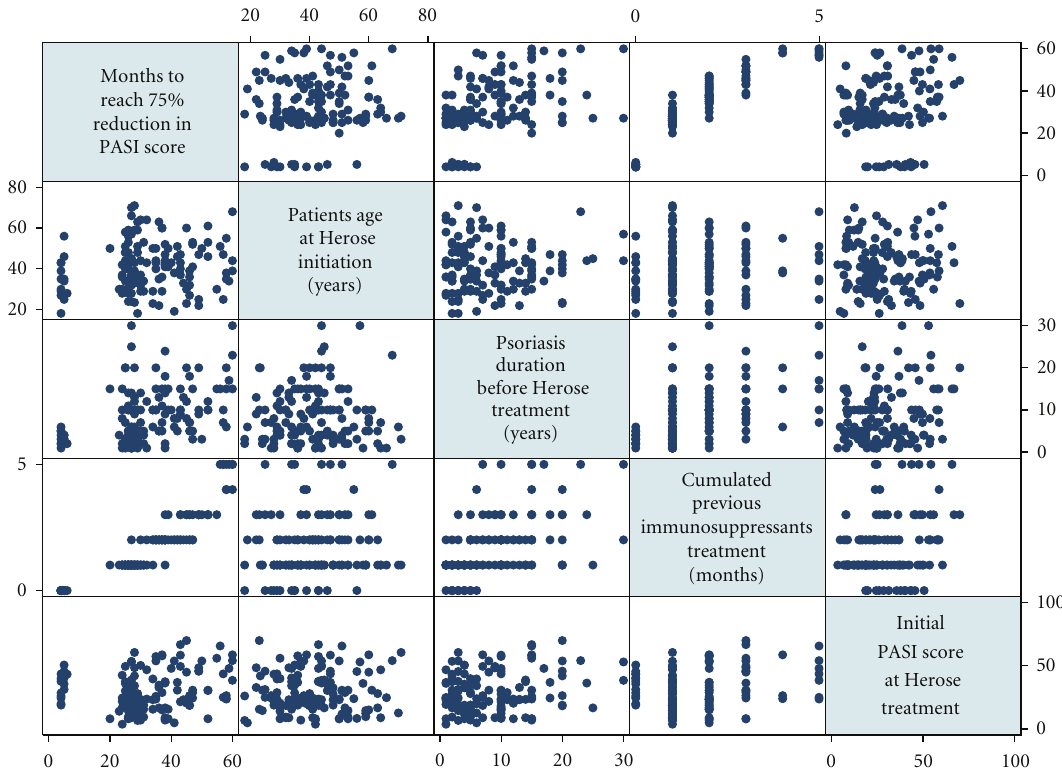
Figure 4: Correlation between months required reaching 75% reduction in PASI score and cumulated prior immunosuppressive treatment is strong ( r = 0 . 9154) however the correlations to other factors, patients age, psoriasis duration, and initial PASI score, are weak ( r = 0 . 1295, 0.4400, 0.1783, resp.). The time to reach PASI75 and clinical clearance significantly depends on the dosage and potency of the immunosuppressants that the patients had formerly consumed.